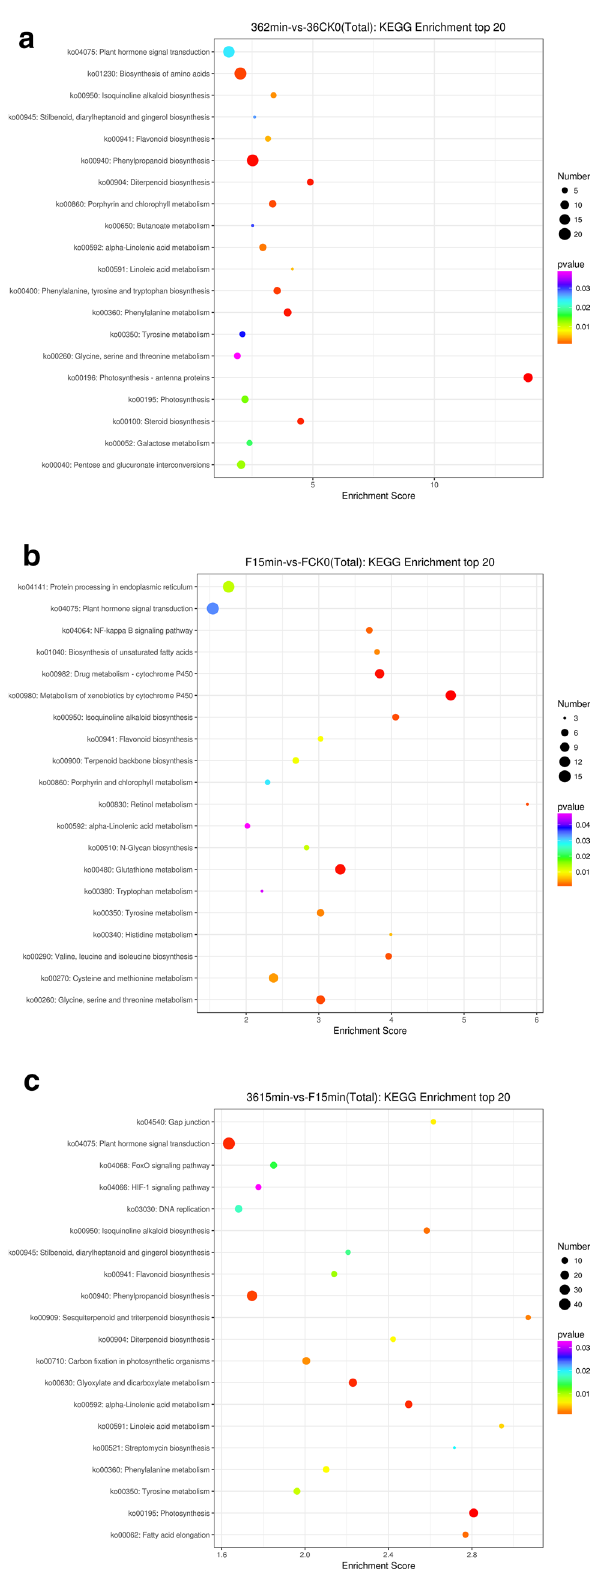
Figure 5. ( a ) KEGG enrichment of the ‘36’ 2 min vs ‘36’ CK0 groups. ( b ) KEGG enrichment of the ‘F’ 15 min vs ‘F’ CK0 groups. ( c ) KEGG enrichment of the ‘36’ 15 min vs ‘F’ 15 min groups. The figures was drawn with DEseq (v3.5.1). (http:// www. bioco nduct or. org/ packa ges/3. 8/ bioc/ html/ DESeq.